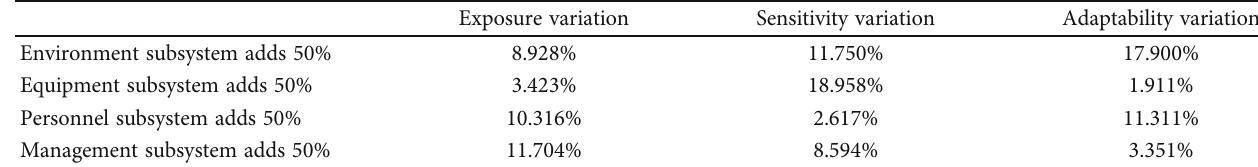
Table 9: Change rate of subsystem.